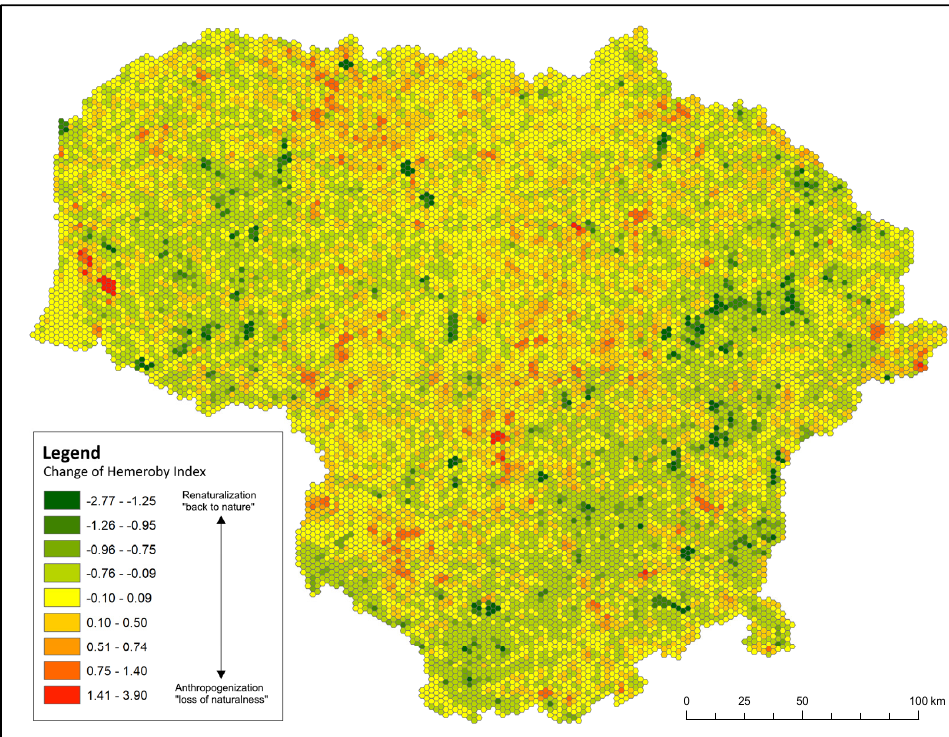
Figure 4. Land-cover change trends (tendencies) 1995–2018.